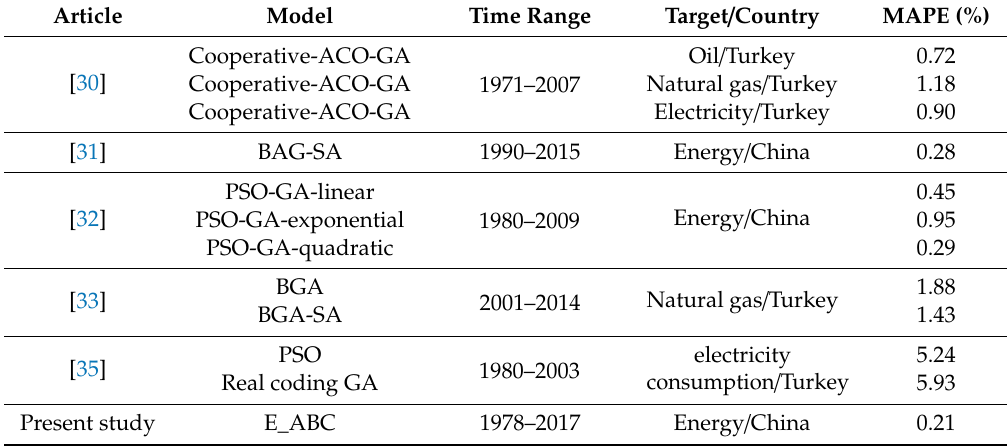
Table 6. MAPE comparison with other forecasting models.